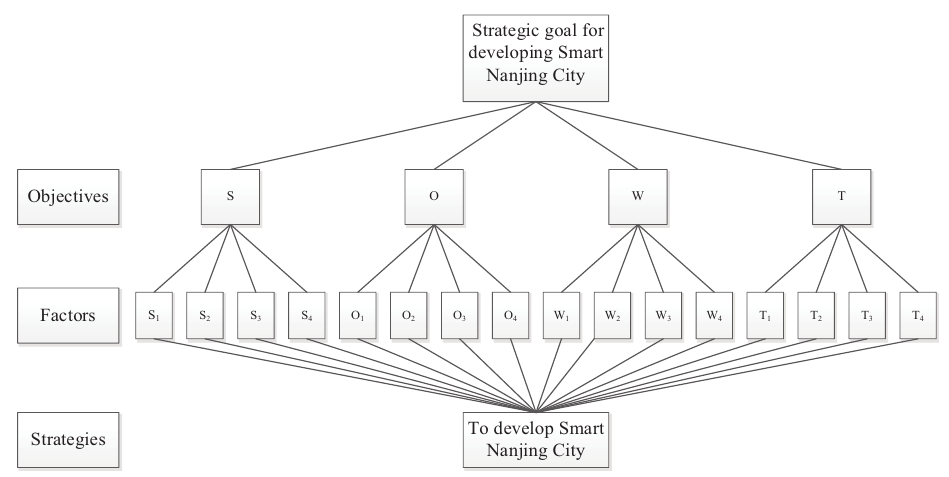
Figure 3. The AHP hierarchy structure for SWOT factors Table 3. The parameters when determining the strategic goal Level Parameters